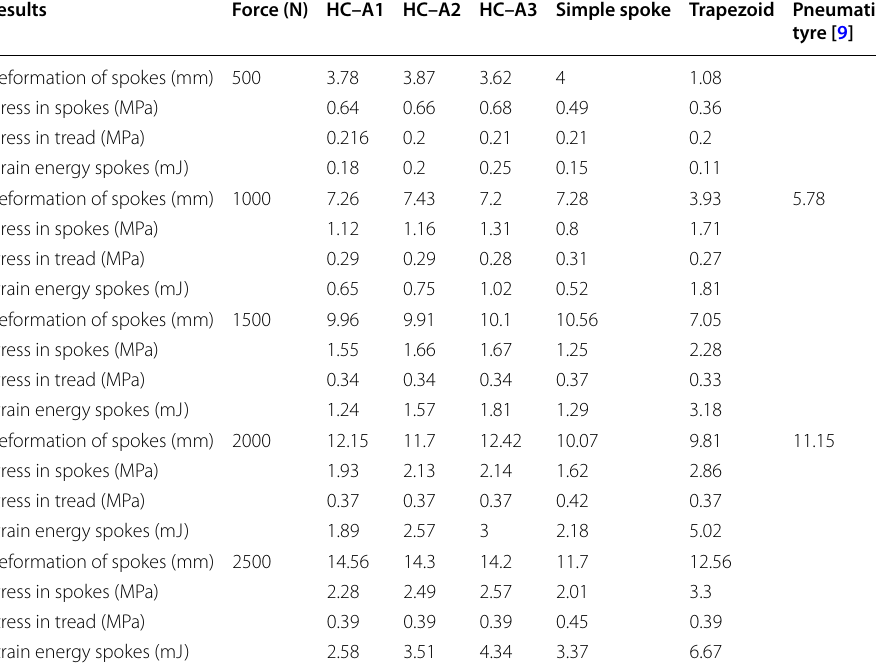
Table 4 Results of all types of NPTs under vertical load/force